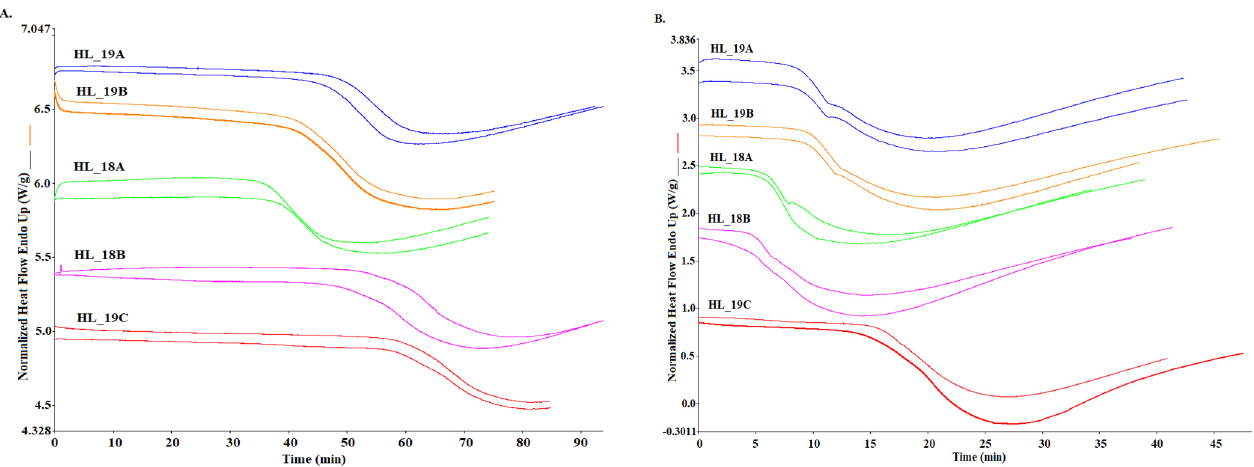
Figure 2. DSC curves obtained for isothermal analysis at ( A ) 120 °C and ( B ) 140 °C temperature program for cold ‐ pressed hemp seed oil. Group 1 oils (HL_18A, HL_18B) and group 2 oils (HL_19A, HL_19B, HL_19C). Table 5. Isothermal assessment of 120, 140, and 160°C temperature programs using differential scanning calorimetry for cold ‐ pressed hemp seed oils .